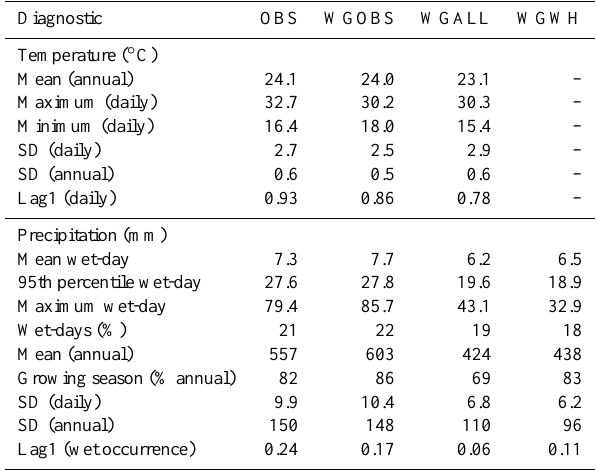
Fig. 15. Cross-validation results for annual mean temperature (AT- BAR). Table 4. Temperature and precipitation diagnostics for Taiz for 1998–2005 derived from observations (OBS) and weather generator parameters calibrated against observations (WGOBS), or estimated from regression models fit to all sites (WGALL), or just those sites on the western escarpment of the Yemen Highlands